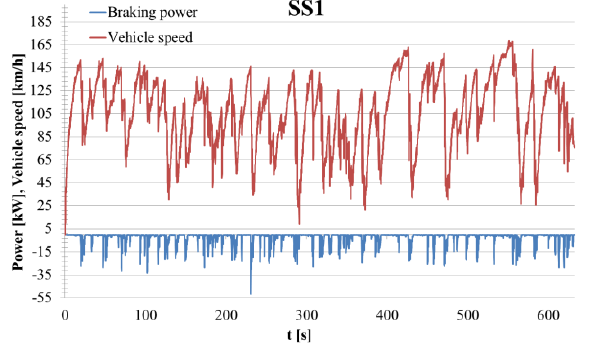
Fig. 4. Braking energy and vehicle speed during